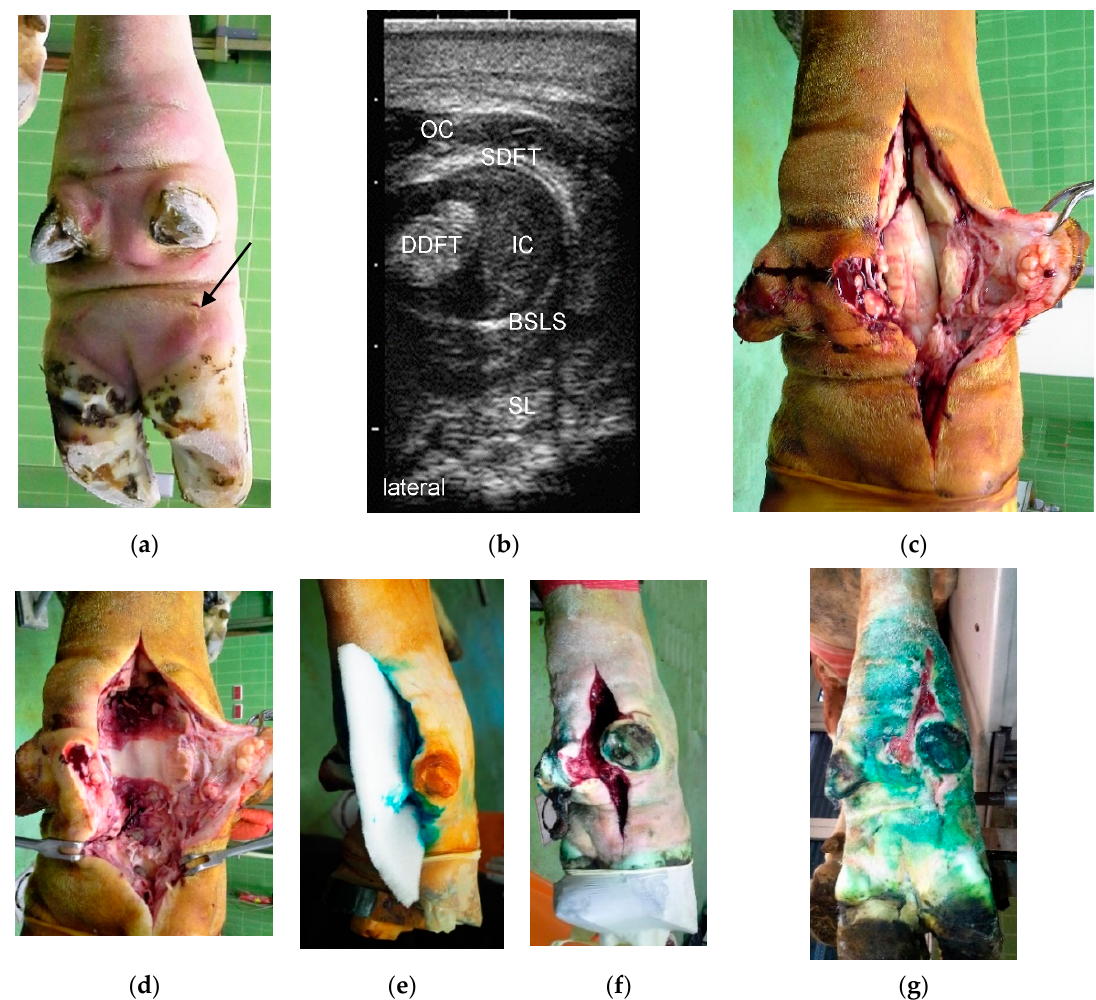
Figure 1. ( a ) Right hind limb of a five-year-old Fleckvieh cow with a four-day old penetrating wound (arrow), which only became apparent after clipping the hair; ( b ) Transversal sonogram (7.5 MHz linear probe) of the lateral DFTS approximately 2 cm proximal to the dewclaw with almost homogenously hypoechoic contents in both severely distended inner and outer compartments of the DFTS and no flow phenomena, indicating a fibrinous effusion. SDFT: superficial digital flexor tendon, DDFT: deep digital flexor tendon, BSLS: branch of the suspensory ligament to SDFT, SL: one of the suspensory ligament branches, OC: outer proximal compartment, IC: inner proximal compartment; ( c ) Intraoperative situation after incision of the lateral DFTS: the lumen is filled entirely with clotted fibrin; ( d ) Intraoperative situation after resection of both DFT, debridement and removal of all fibrin. The dorsal wall of the DFTS in severely hyperemic; ( e ) Use of sterile polyurethane soft foam as a drain; ( f ) Status three days after surgery during the first bandage change with a marked reduction in swelling and formation of granulation tissue; ( g ) Status at 12 days postsurgery with the wound almost entirely filled with healthy granulation tissue. Note that no part of the wound was sutured. After removal of the drain seven days post-surgery, the bandage facilitated satisfactory reduction of the width of the wound.